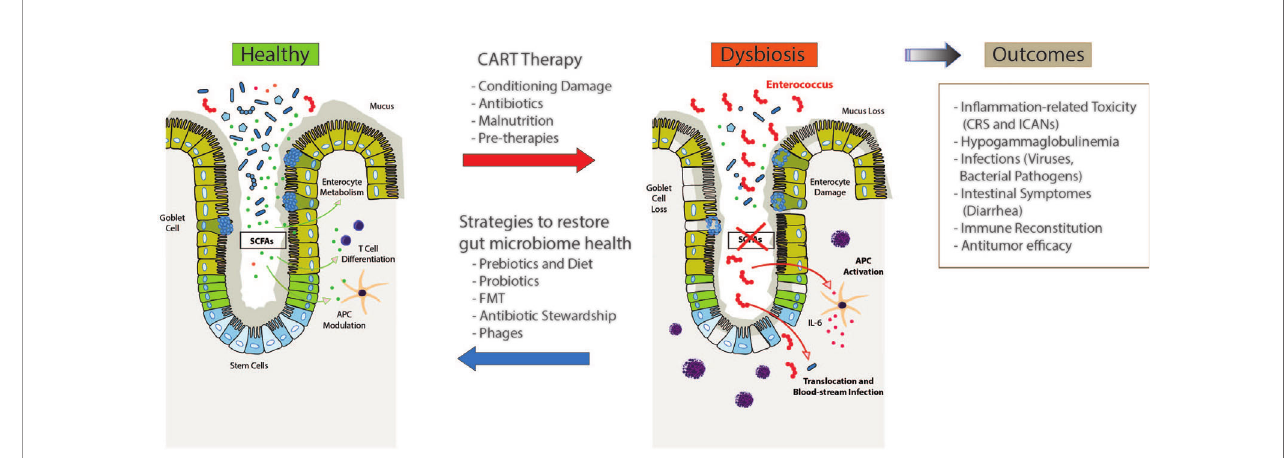
FIGURE 2 | Intestinal microbiome dysbiosis and potential associations with patient outcomes following therapy with chimeric antigen receptor (CAR)-T cells (CART). Patients receiving CARTs are exposed to various environmental conditions including cytotoxic conditioning regimens, antibiotics, and dietary changes or malnutrition that might contribute to changes in the intestinal microbiome. In addition, previous therapies including chemotherapy, stem cell transplantation or even surgeries can affect microbiome homeostasis. These injuries to the intestinal microbiome, in turn, are hypothesized to affect clinical outcome and toxicity to CART treatment, including cytokine release syndrome (CRS), immune effector cell-associated neurotoxicity syndrome (ICANs), infections, gastrointestinal adverse events, immune reconstitution, and relapse through various different immunological mechanisms involving different hematopoietic and non-hematopoietic cell populations. Several strategies have been proposed, although not speci fi cally for CAR-T cell immunotherapy, to restore the intestinal microbiome health which comprise pre- and probiotics, fecal microbiome transfer (FMT), de-escalated antibiotic exposures or even phage-based therapies to mitigate expansion of potential